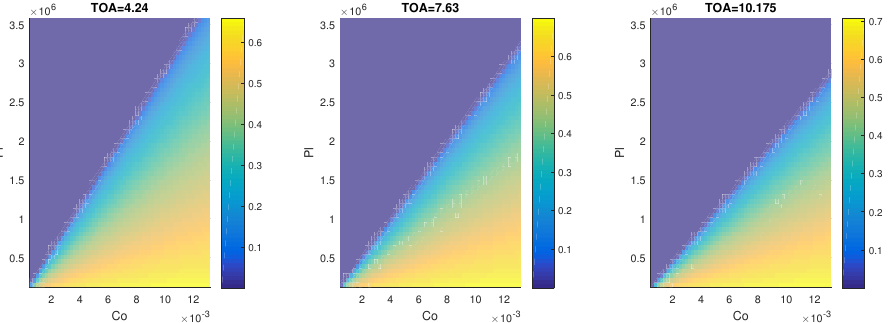
Figure 4. Amplitude of the mass flow rate oscillations as a function of Co and Pl for different values of TOA .